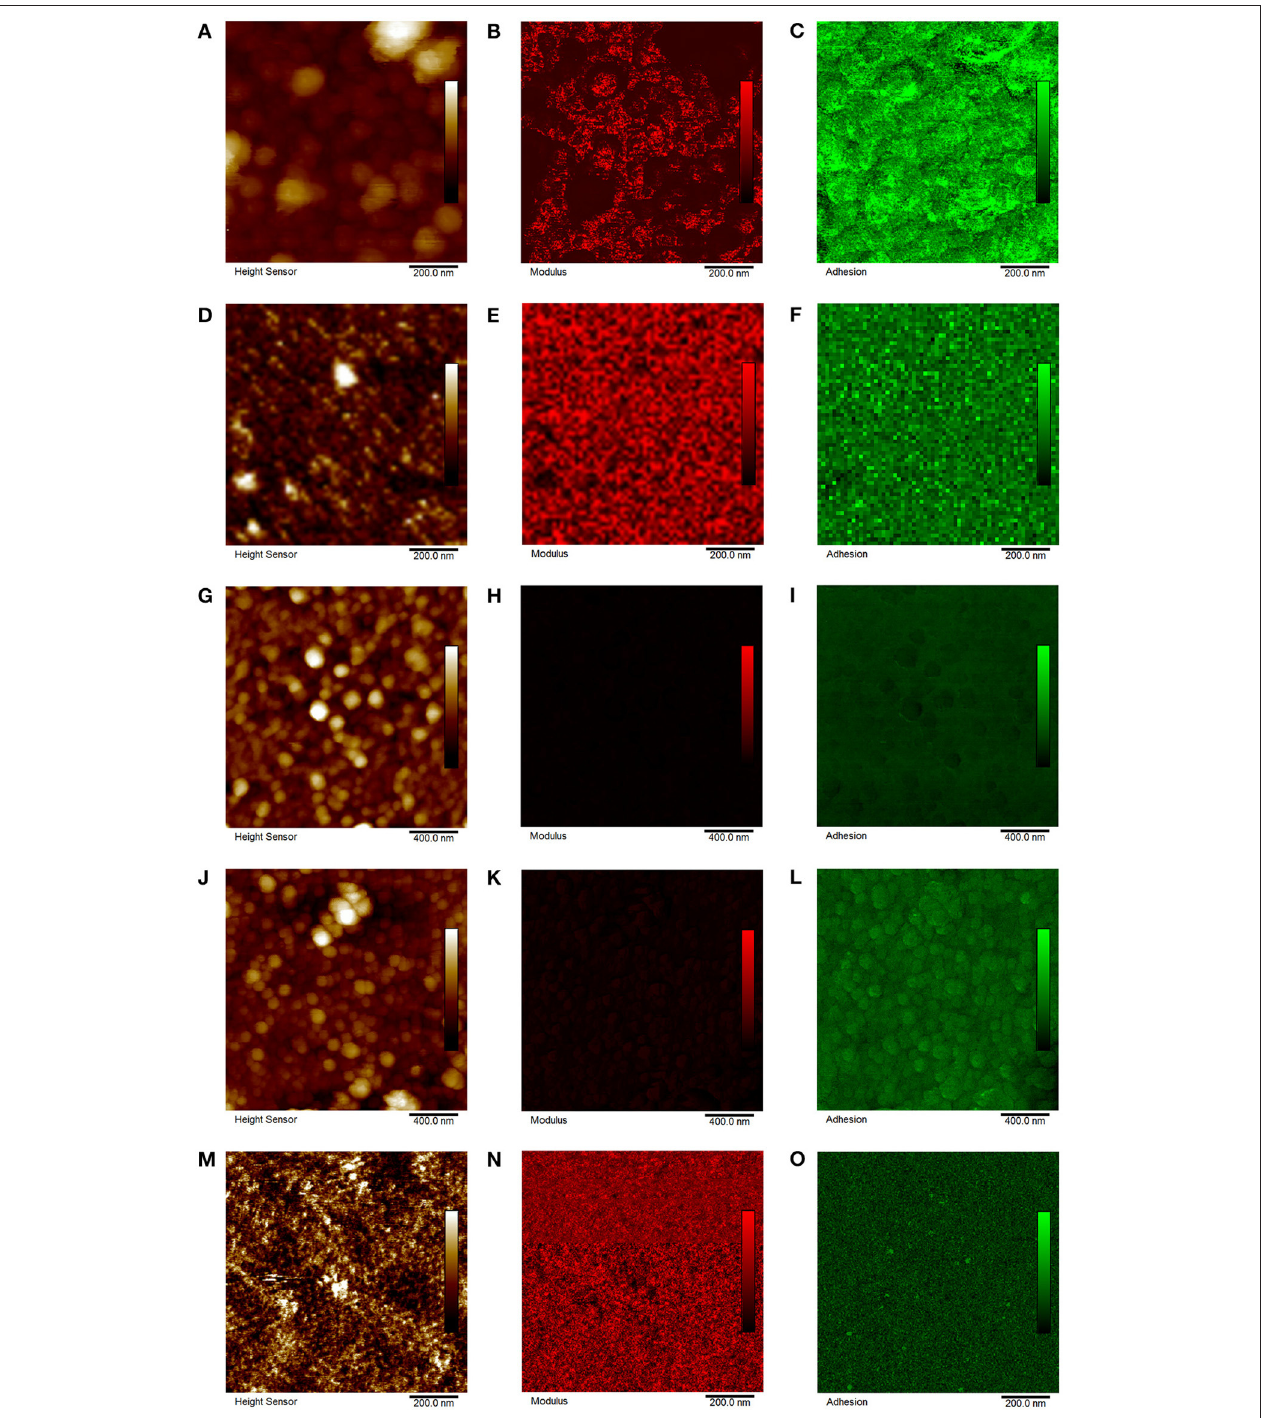
FIGURE 3 | Nanomechanical mapping of (A–C) rSfp1 Beta C-term 450mM NaCl, (D–F) rSfp1 Delta ASW, (G–I) rSfp1 Delta 150mM CaCl 2 , (J–L) mix of rSfp1 Beta C-term and rSfp1 Delta ASW, (N–P) Bovine serum albumin ASW using Peak Force QNM mode in fluid (observations made in deionized water). (A) Height, scale: 200 nm, (B) Modulus, scale: 10 MPa, (C) Adhesion, scale: 500 pN, (D) Height, scale: 15 nm, (E) Modulus, scale: 10 MPa, (F) Adhesion, scale: 500 pN, (G) Height, scale: 70 nm, (H) Modulus, scale: 10 MPa, (I) Adhesion, scale: 500 pN, (J) Height, scale: 115 nm, (K) Modulus, scale: 10 MPa, (L) Adhesion, scale: 500 pN, (M) Height, scale: 2.5 nm, (N) Modulus, scale: 10 MPa, and (O) Adhesion, scale: 500